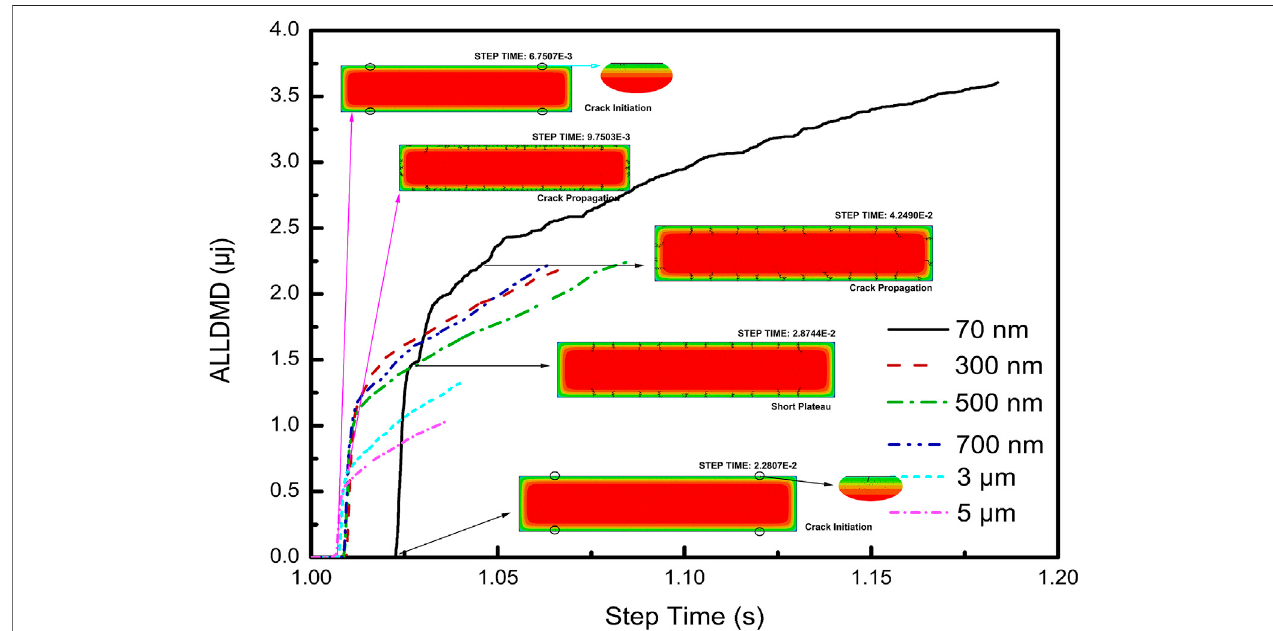
FIGURE 5 | ALLDMD curves of different grain size models.